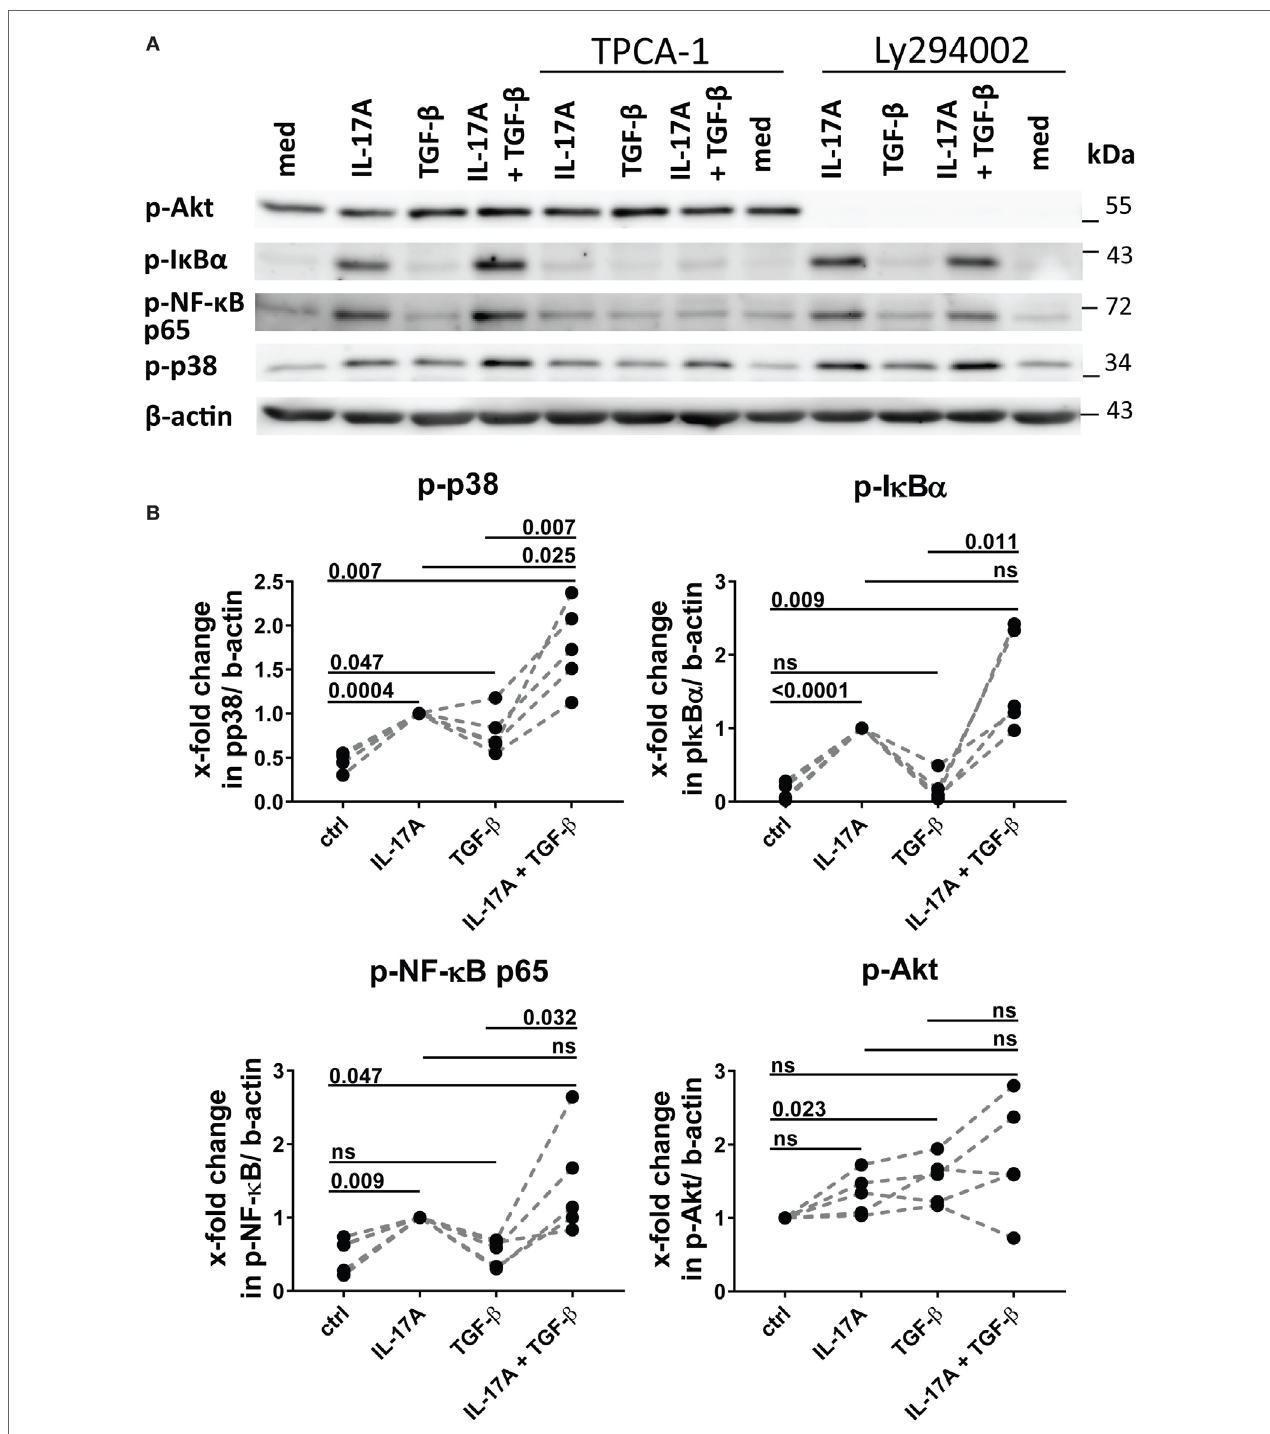
FigUre 6 | Phosphorylation of MAPK p38 is enhanced by the combined action of IL-17A and TGF- β . (a) Western blot (WB) of healthy donors fibroblasts treated with 1 µM TPCA-1 and/or 10 µM Ly294002 for 1 h prior to addition of IL-17A (25 ng/ml) and/or TGF- β (2.5 ng/ml) and cultured for an additional 10 min. Results are representative of three experiments with inhibitors and two additional experiments with cytokines only. (B) Quantification of Western blot (WB) analysis was performed with ImageJ software (http://rsbweb.nih.gov/ij) and values were normalized to β -actin, N = 5. Results are shown as fold change to IL-17A-treated cells (for p-p38, p-I κ B α , and p-NF- κ B p65) or to untreated cells (for p-Akt), N = 5. Significance assessed by paired t test.